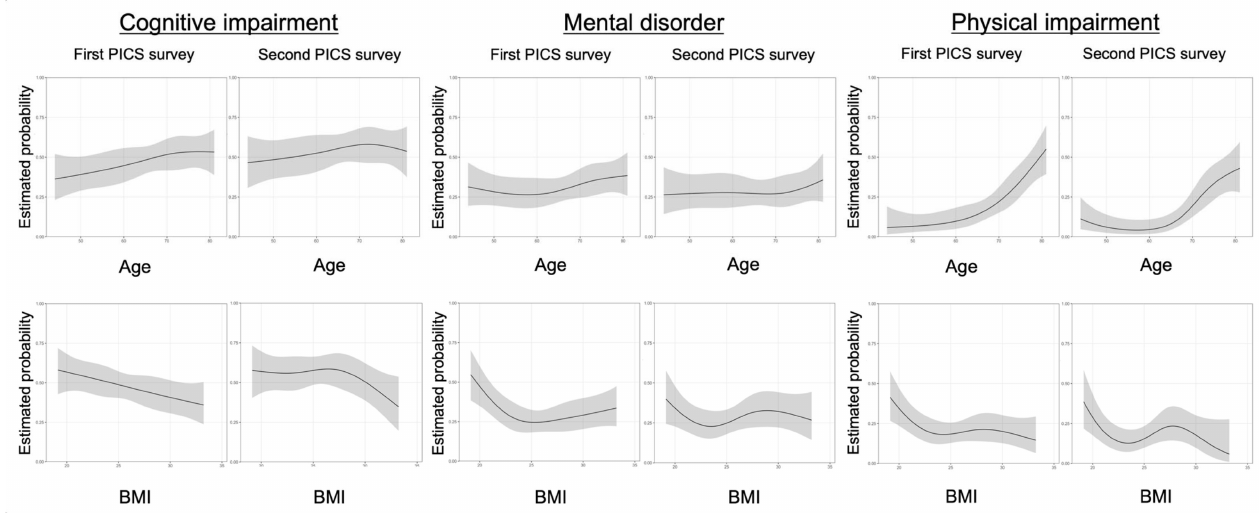
Figure 6. The relationship between three elements of post-intensive care syndrome (PICS) and age/body mass index by spline curves. The relationship between cognitive impairment/mental disorder/physical impairment and age/body mass index (BMI) was depicted using spline curves, and univariate logistic regression analysis was performed using a restricted cubic spline model. A nonlinear cubic spline curve was drawn with the estimated probability and 95% confidence intervals for the outcomes. BMI: body mass index; MV: mechanical ventilation; PICS: post-intensive care